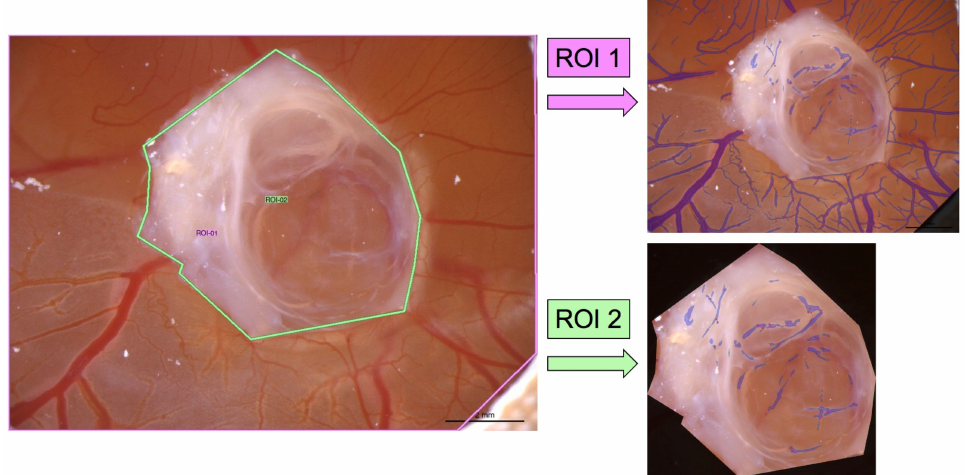
Figure 3. Definition of regions of interest (ROIs) in the CAM assay application. The first ROI (ROI 1) was defined as the total CAM with the engrafted cystic tissue samples. The second ROI (ROI 2) only contained the cystic tissue. The values of ROI 2 were subtracted from the results of ROI 1 to ensure that false positive vessel detections in the cystic tissue were excluded from the